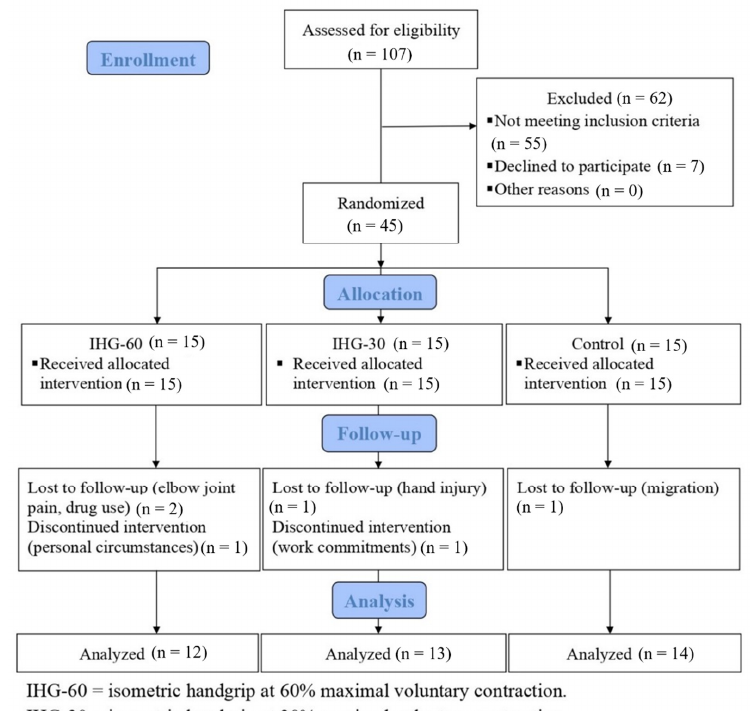
Figure 1. Study flow chart.